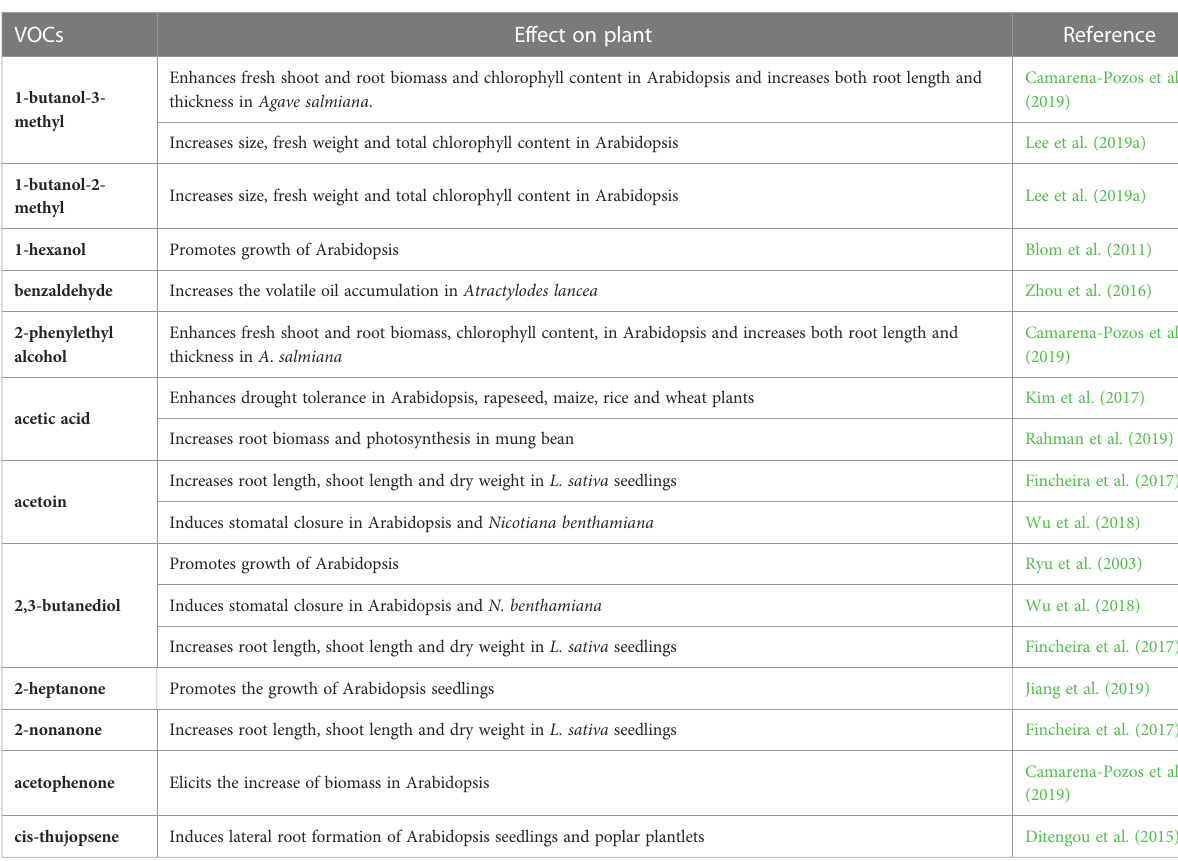
TABLE 3 List of potentially relevant bioactive VOCs present in at least one of the fungal CFs used by Baroja-Ferna ́ ndez et al. (2021) and their effects on plant. VOCs Effect on